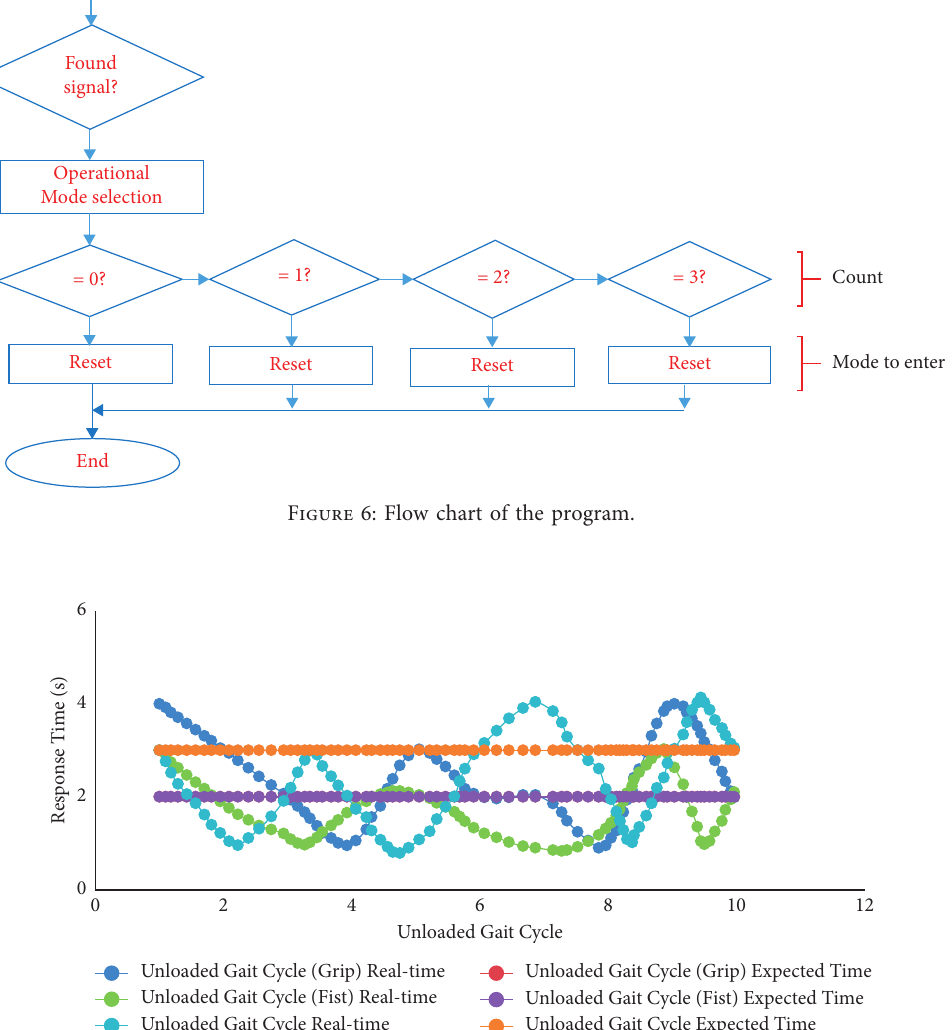
Figure 6: Flow chart of the program.